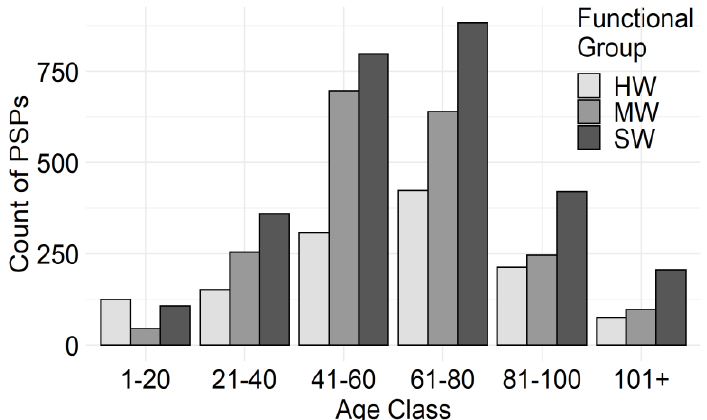
Figure 4. Age distribution of Nova Scotia Permanent Sample Plots (PSPs) as a function of the hardwood (≥75% HW), mixed wood (MW), and softwood (≥75% SW) functional groups (after age calculation-related omissions). n = 6049.